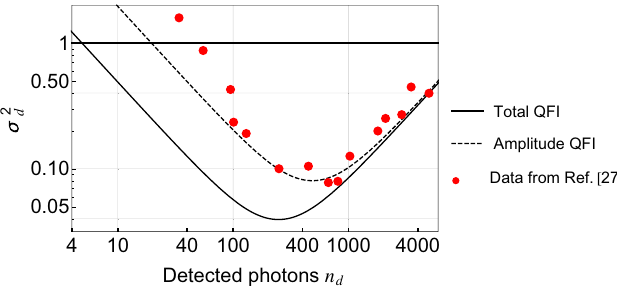
(variance of d first d